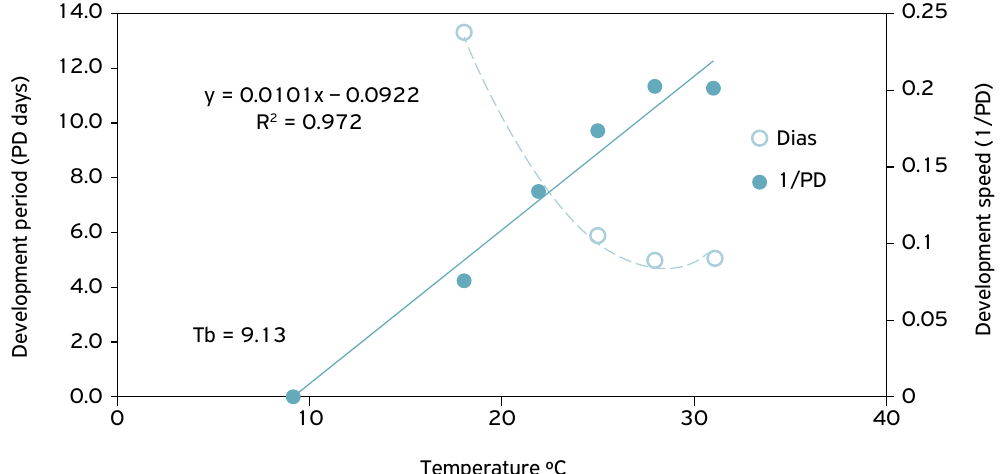
Figure 1. Relationship between temperature, time (days) and developmental speed of the Aphis craccivora nymphal period in cowpeas kept at the constant temperatures of 18, 22, 25, 28 and 32ºC with a photophase of 12